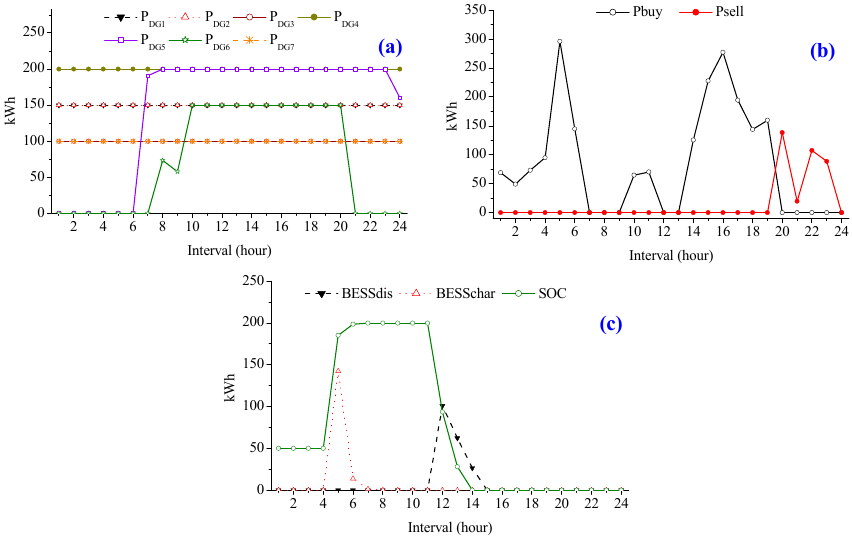
Figure 9. Operation results of normal case: ( a ) output power of DG units; ( b ) the amount of exchanging power; and ( c ) the charging/discharging amount and the SOC of BESS.